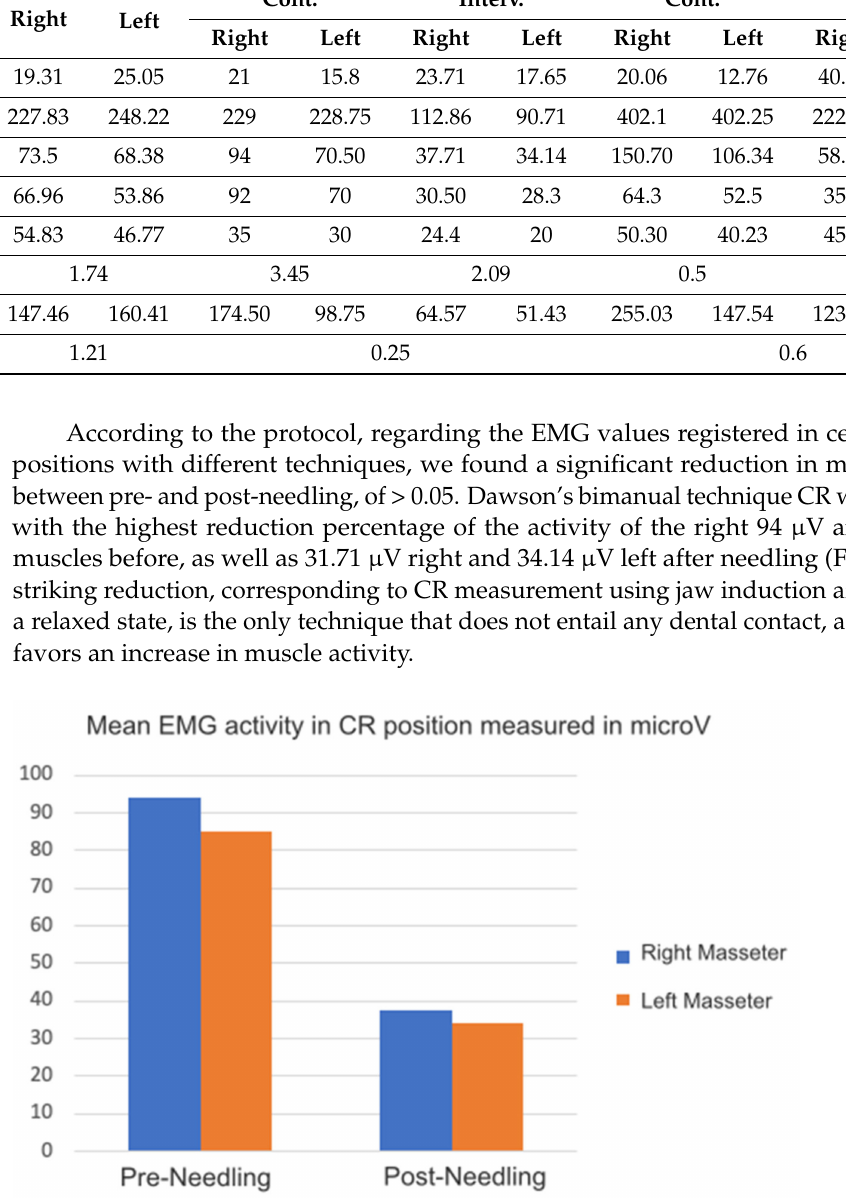
Figure 5. Graph of EMG activity in CR position compared with other techniques (CR-P, CR-L), Table